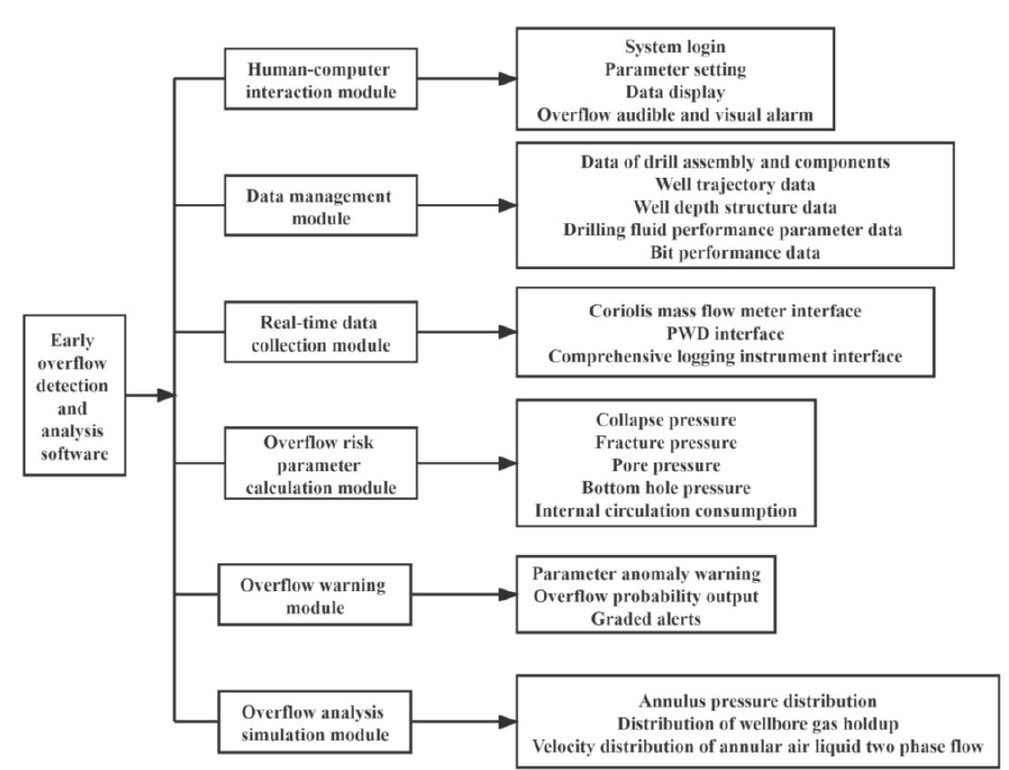
Figure 5. Software design architecture.